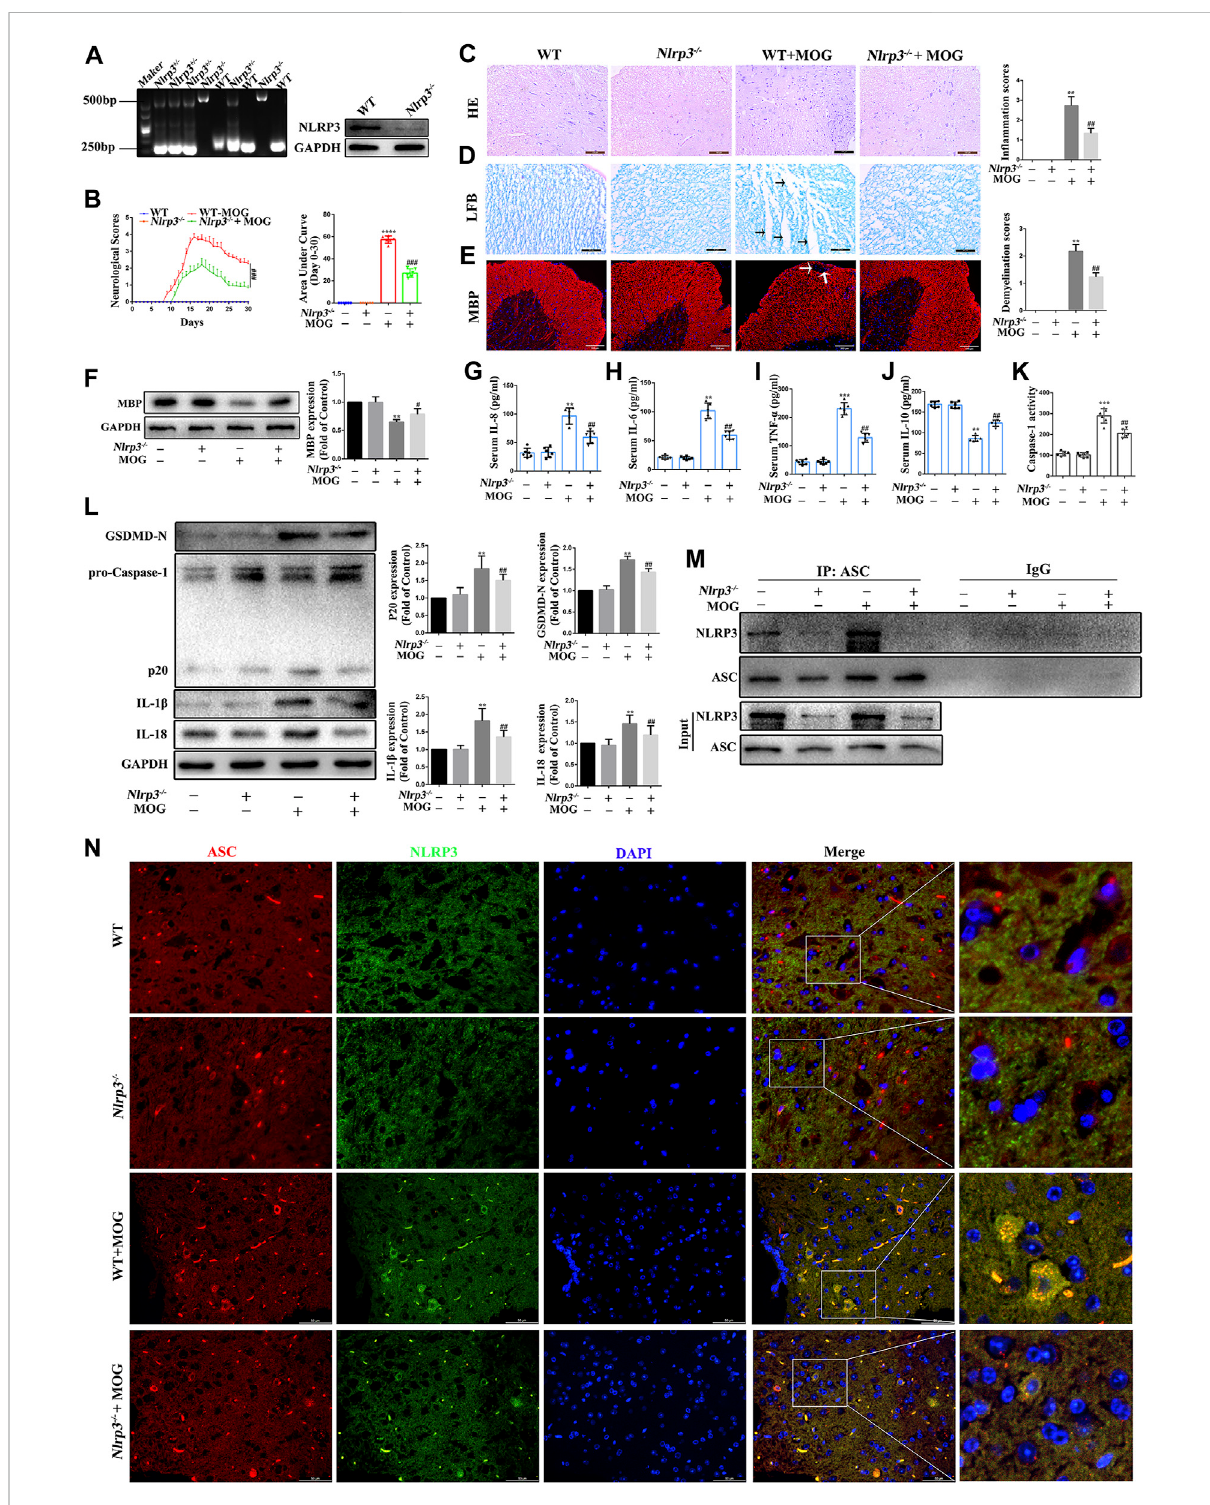
FIGURE 6 NLRP3 in fl ammasome mediated pyroptosis plays an important role in the pathogenesis of EAE (A) Identi fi cation of Nlrp3 knockout (KO) mice. (B) Clinicalbehavioralscoresandtheareaunderthecurve(AUC). (C) H&Estainingwasperformedonparaf fi n-embeddedmousespinalcordsections (scale bars: 100 μ m). (D) LFB staining was performed on paraf fi n-embedded mouse spinal cord sections (The arrows present myelin injury and loss, scalebars:50 μ m). (E) Immuno fl uorescencestainingofMBPinthespinalcord(Thearrowspresentmyelininjuryandloss,scalebars:100 μ m).